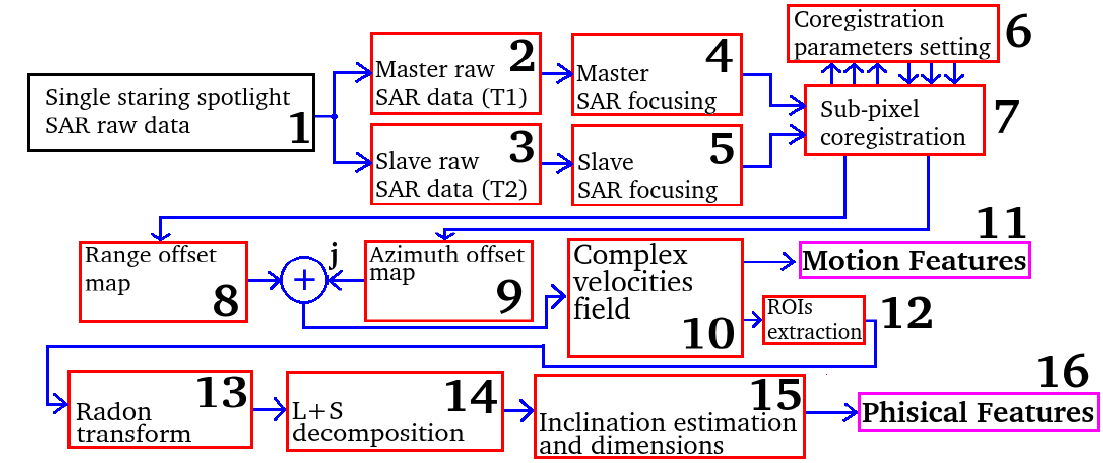
Figure 5. Computational scheme for features